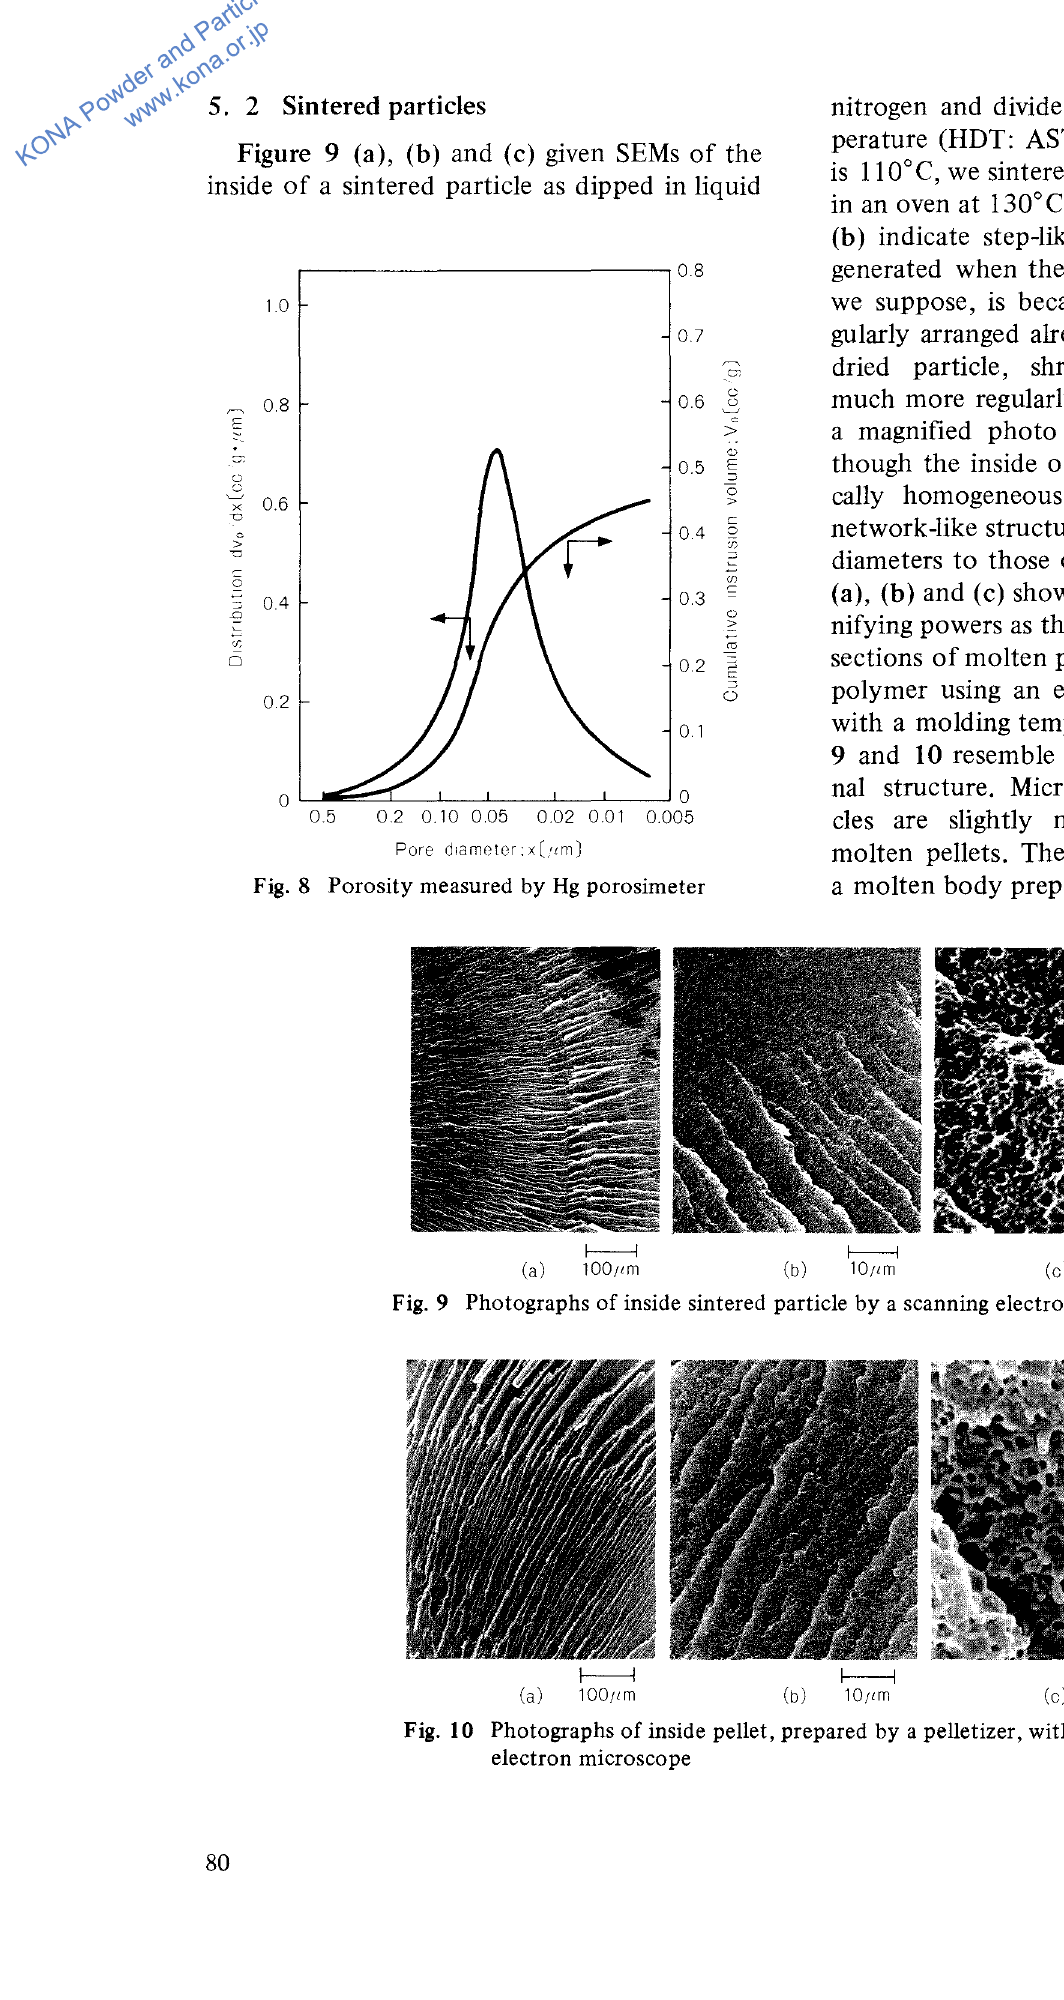
Fig. 10 Photographs of inside pellet, prepared by a pelletizer, with a scanning electron